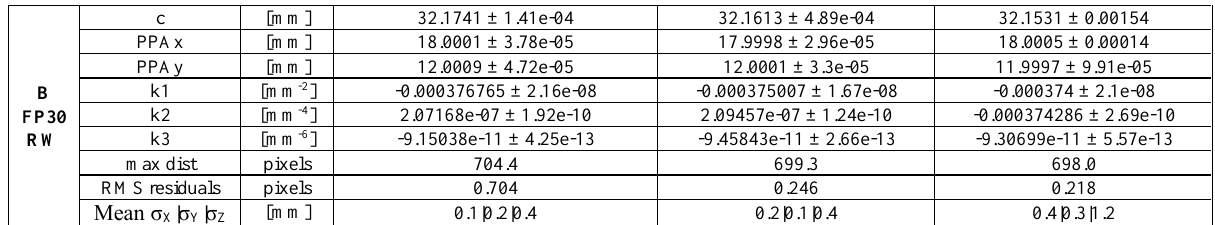
Table 3. Results of the bundle adjustment with self-calibration for the simulated dataset B, using radial weighting (RW). After applying the proposed method, the systematic harmonic pattern (Figure 6-a) is flattened and reduced in magnitude (Figure